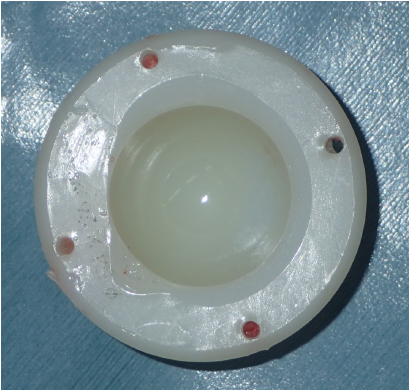
Figure 3. Retrieved annealed highly crosslinked polyethylene after total hip arthroplasty showing rim deformation due to impingement. The surface of the weight-bearing area was yellowish and considerably oxidized.